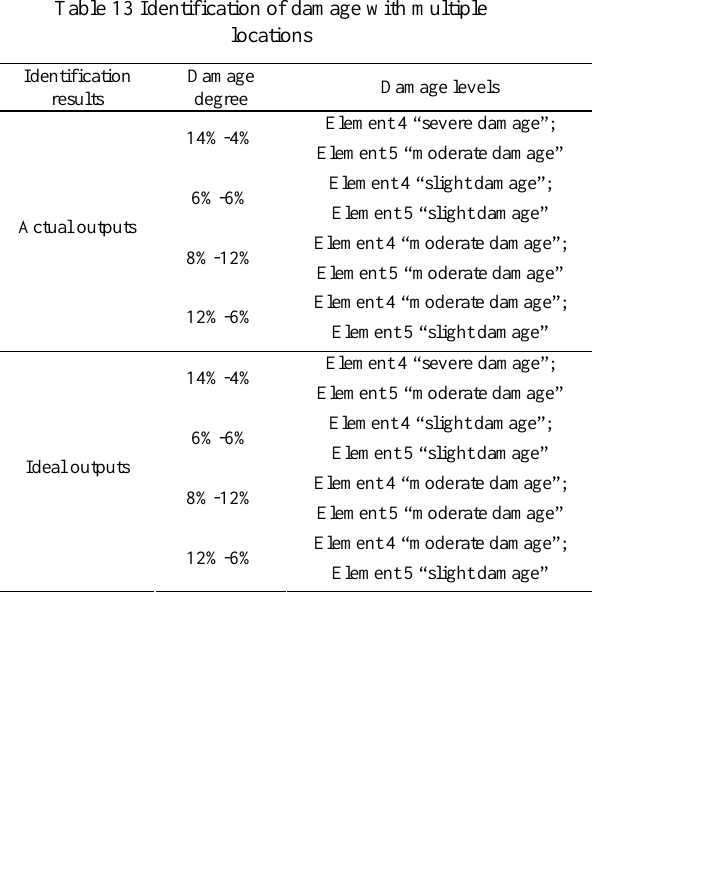
Table 13 Identification of damage with multiple